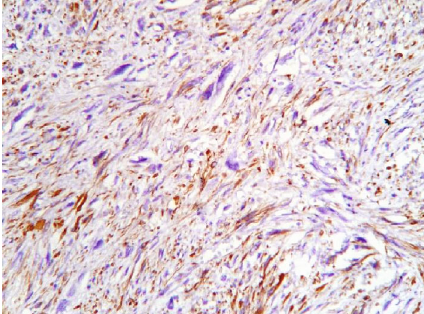
Figure 7: Poorly di ff erentiated malignant mesenchymal tumor. Immunohistochemistry assay with desmin antibodies. Positive reaction in tumor cells